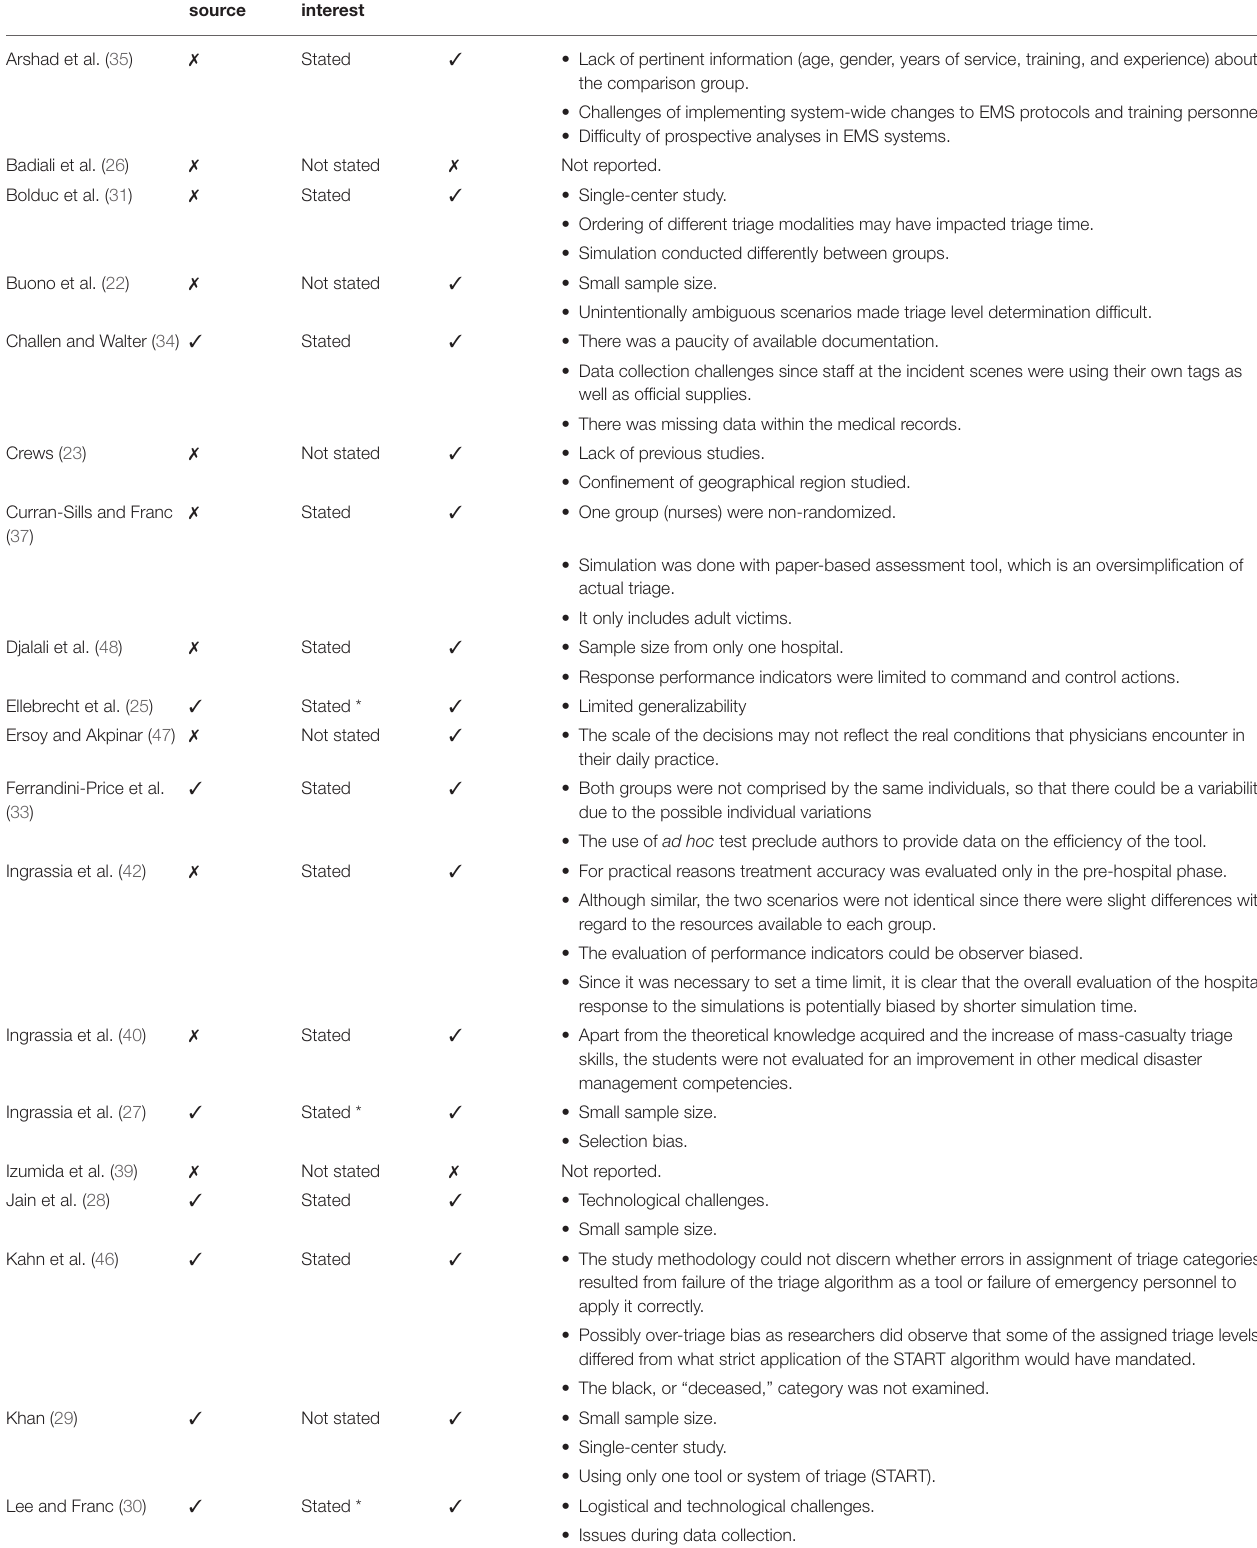
TABLE 2 | Transparency of the